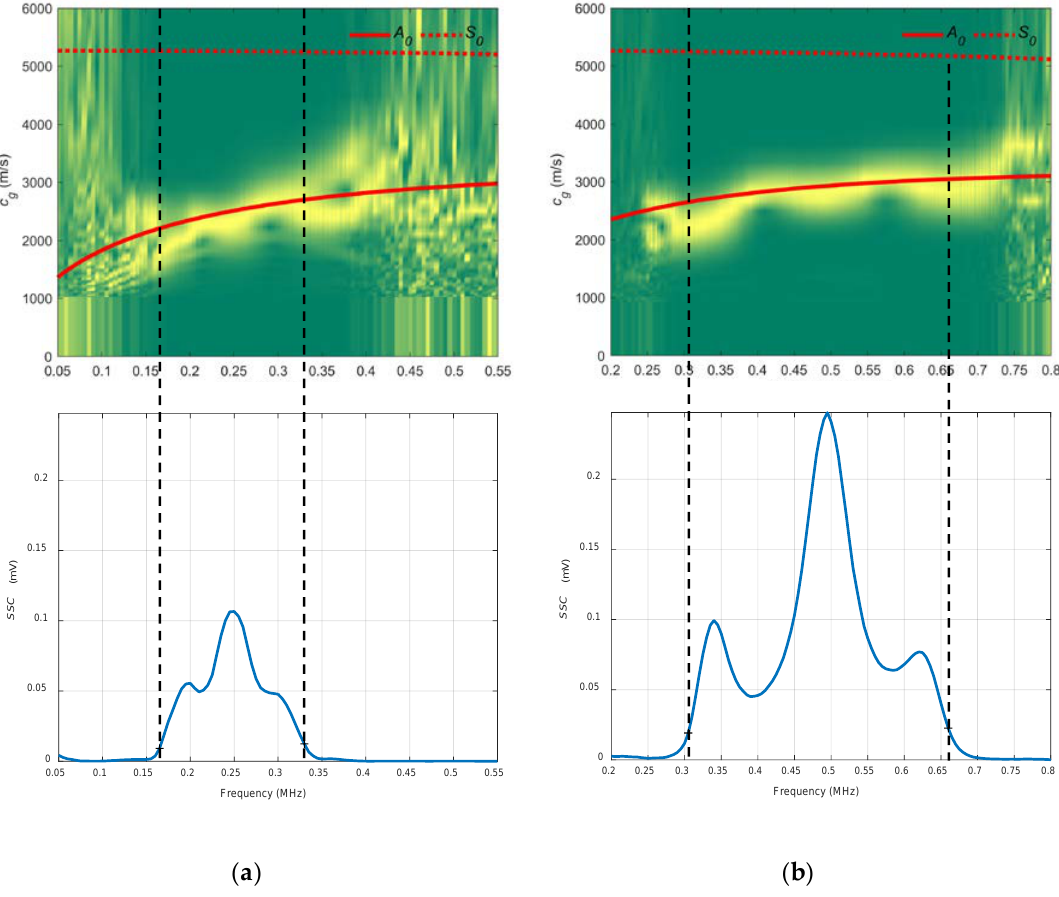
Figure 15. Combined spectrograms and system sensitivity curves ( SSC ) from the air coupling setup to measure the stainless-steel plate: ( a ) 13.75°, 250 kHz transducers; ( b ) 10°, 500 kHz transducers.